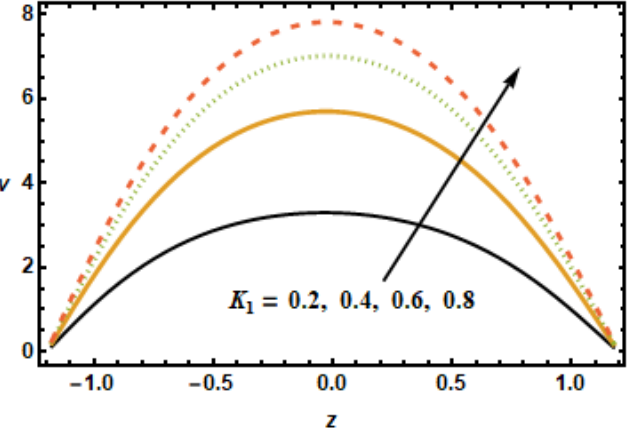
Figure 10. Dependence of v on volume fraction φ .